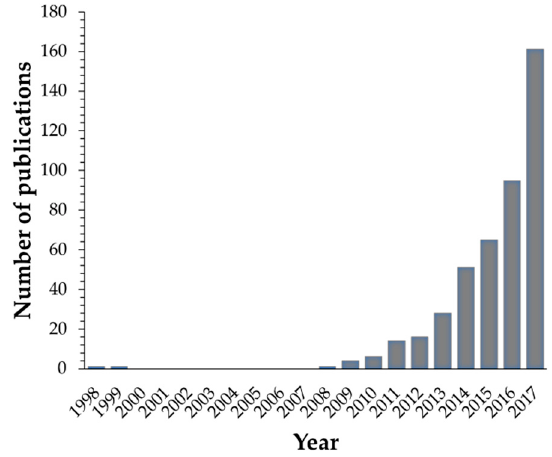
Figure 10. Evolution of publications over the past 20 years on the subject “self-healing hydrogels” (database used for the bibliographic analysis: Scopus ® (Elsevier, Amsterdam, The Netherlands consulted on the 3th of May 2018).